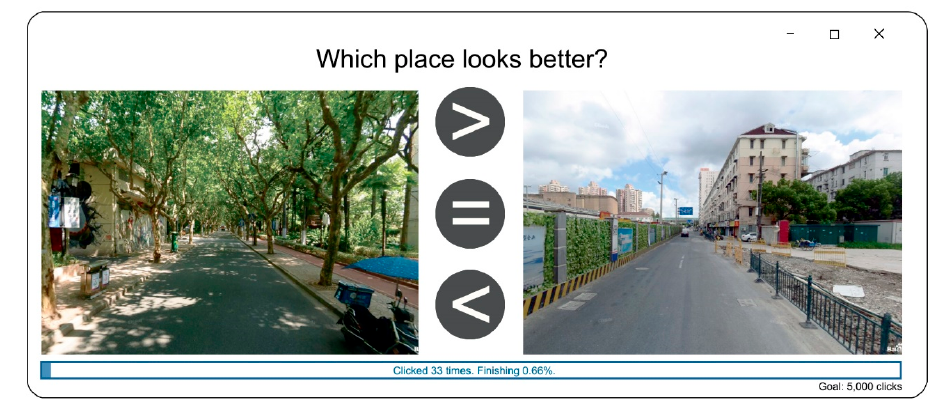
Figure 7. Applying SegNet to extract key spatial elements.